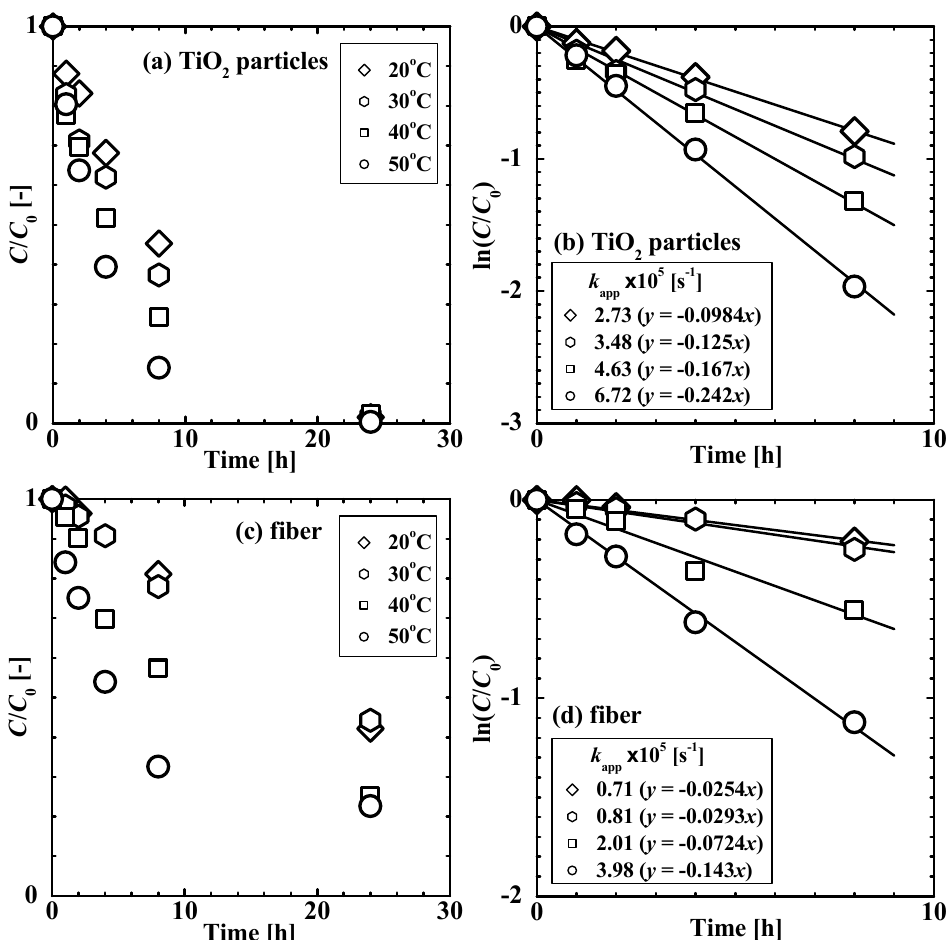
Figure 4. Kinetics of the degradation of 4-isopropylphenol photocatalyzed by ( a , b ) TiO 2 nanoparticles and ( c , d ) the TiO 2 nanoparticle-loaded fiber at various temperatures. ( a , c ) Time course of the concentration ratio, C / C 0 . ( b , d ) Analysis of the degradation kinetics using a pseudo-first-order reaction model (Equation (1)).